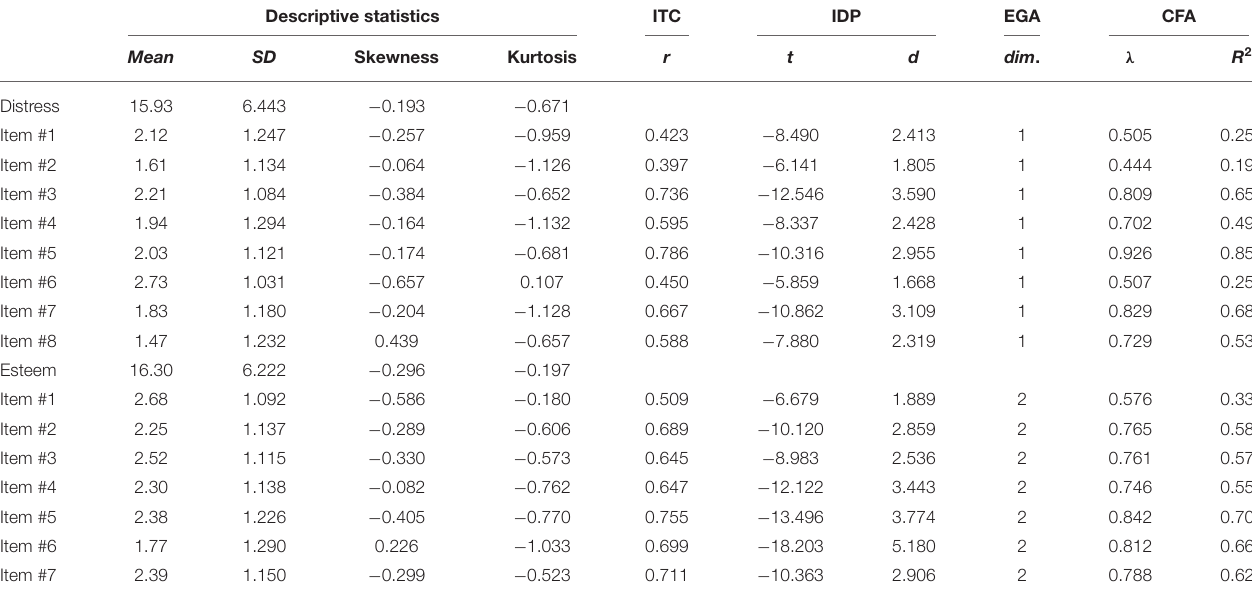
TABLE 2 | Study 1: psychometric properties of items.